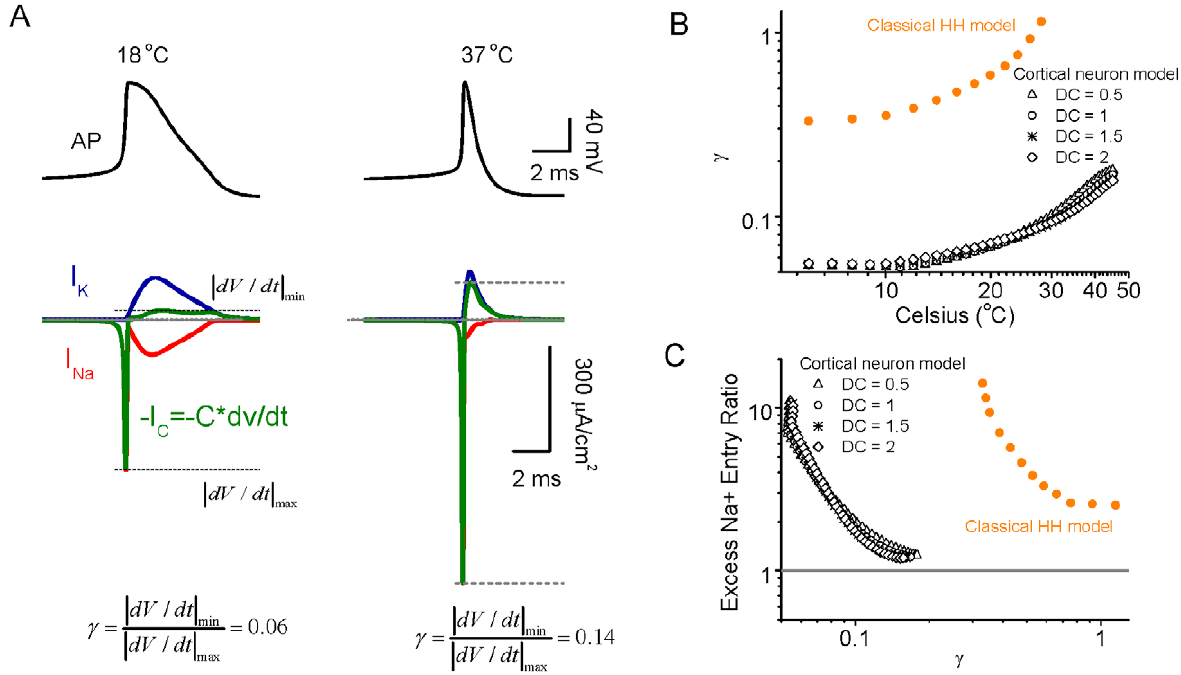
Figure 3. The ratio of absolute minimal dV/dt to maximal dV/dt is affected by the overlap level of Na + and K + currents. A. For a given action potential at 18 u C, the Na + and K + currents have a large overlap, resulting in a cancelled effect in the total membrane charge current C*dV/dt and the ratio of absolute minimal dV/dt to maximal dV/dt ratio is small, approximately 0.06. For a given action potential at 37 u C, the Na + and K + currents exhibit significantly less overlap, leading to a relatively large minimal dV/dt peak (similar in amplitude-time course as I K ), while the maximal dV/dt peak resembles the amplitude-time course of I Na . The absolute minimal dV/dt to maximal dV/dt is increased to 0.14. B. The ratio c (defined as the ratio of absolute minimal dV/dt to maximal dV/dt) increases as a function of temperature for both classical HH neuron and cortical neuronal models, owing largely to the decrease in overlap of Na + and K + currents with increases in temperature. C. The excess Na + entry ratio decreases as a function of c for both HH and cortical neuronal